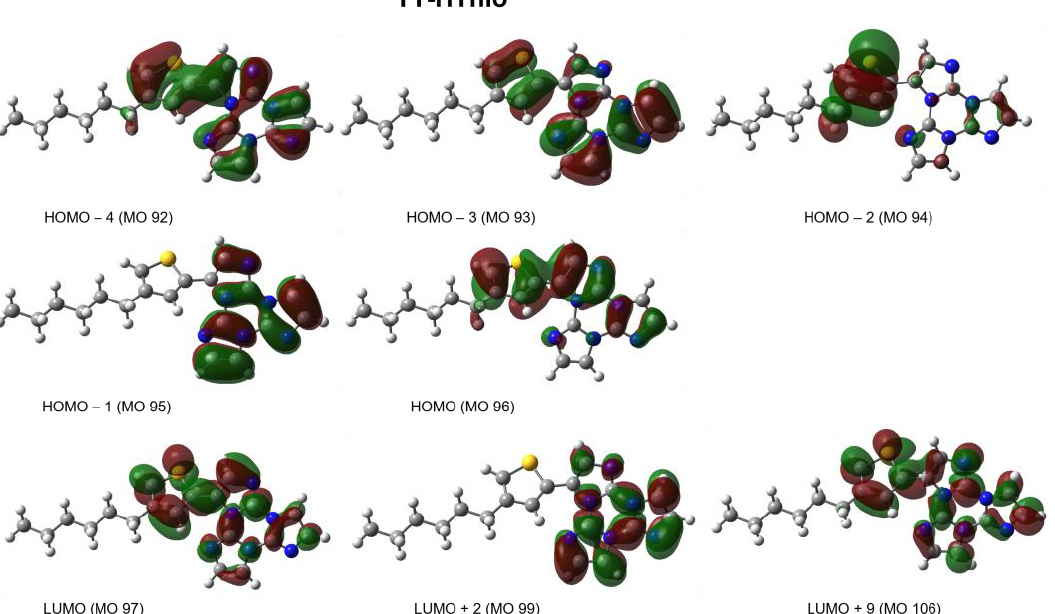
Figure 8. Plots of the ω B97X/6-311++G(d,p) MOs mainly involved in the lowest energy transitions of TT-HThio (isosurfaces value 0.02).